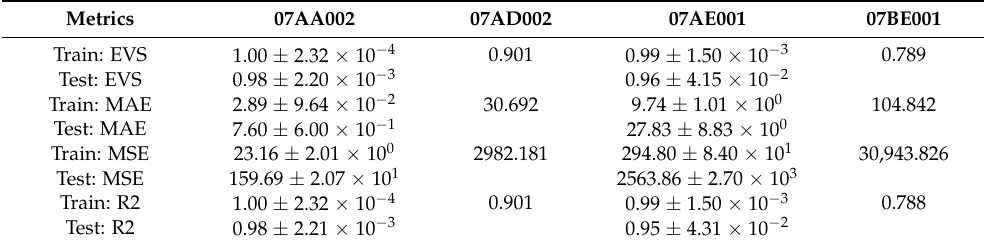
Table 3. Accuracy test by various metrics for SARIMA modeling (07AD002 and 07BE001) and RFR modeling (07AA002 and 07AE001). The ideal value for Explained Variance Score (EVS) and the coefficient of determination (R2) is a number close to one, while the ideal value for the Mean Absolute Error (MAE) and the Mean Squared Error (MSE) is a number close to